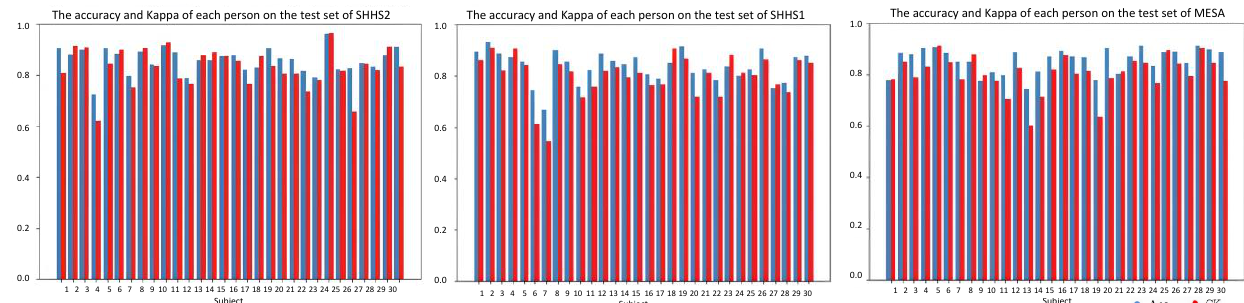
Figure 7. An example of the accuracy (ACC) and Kappa (CK) of each subject in the test sets.